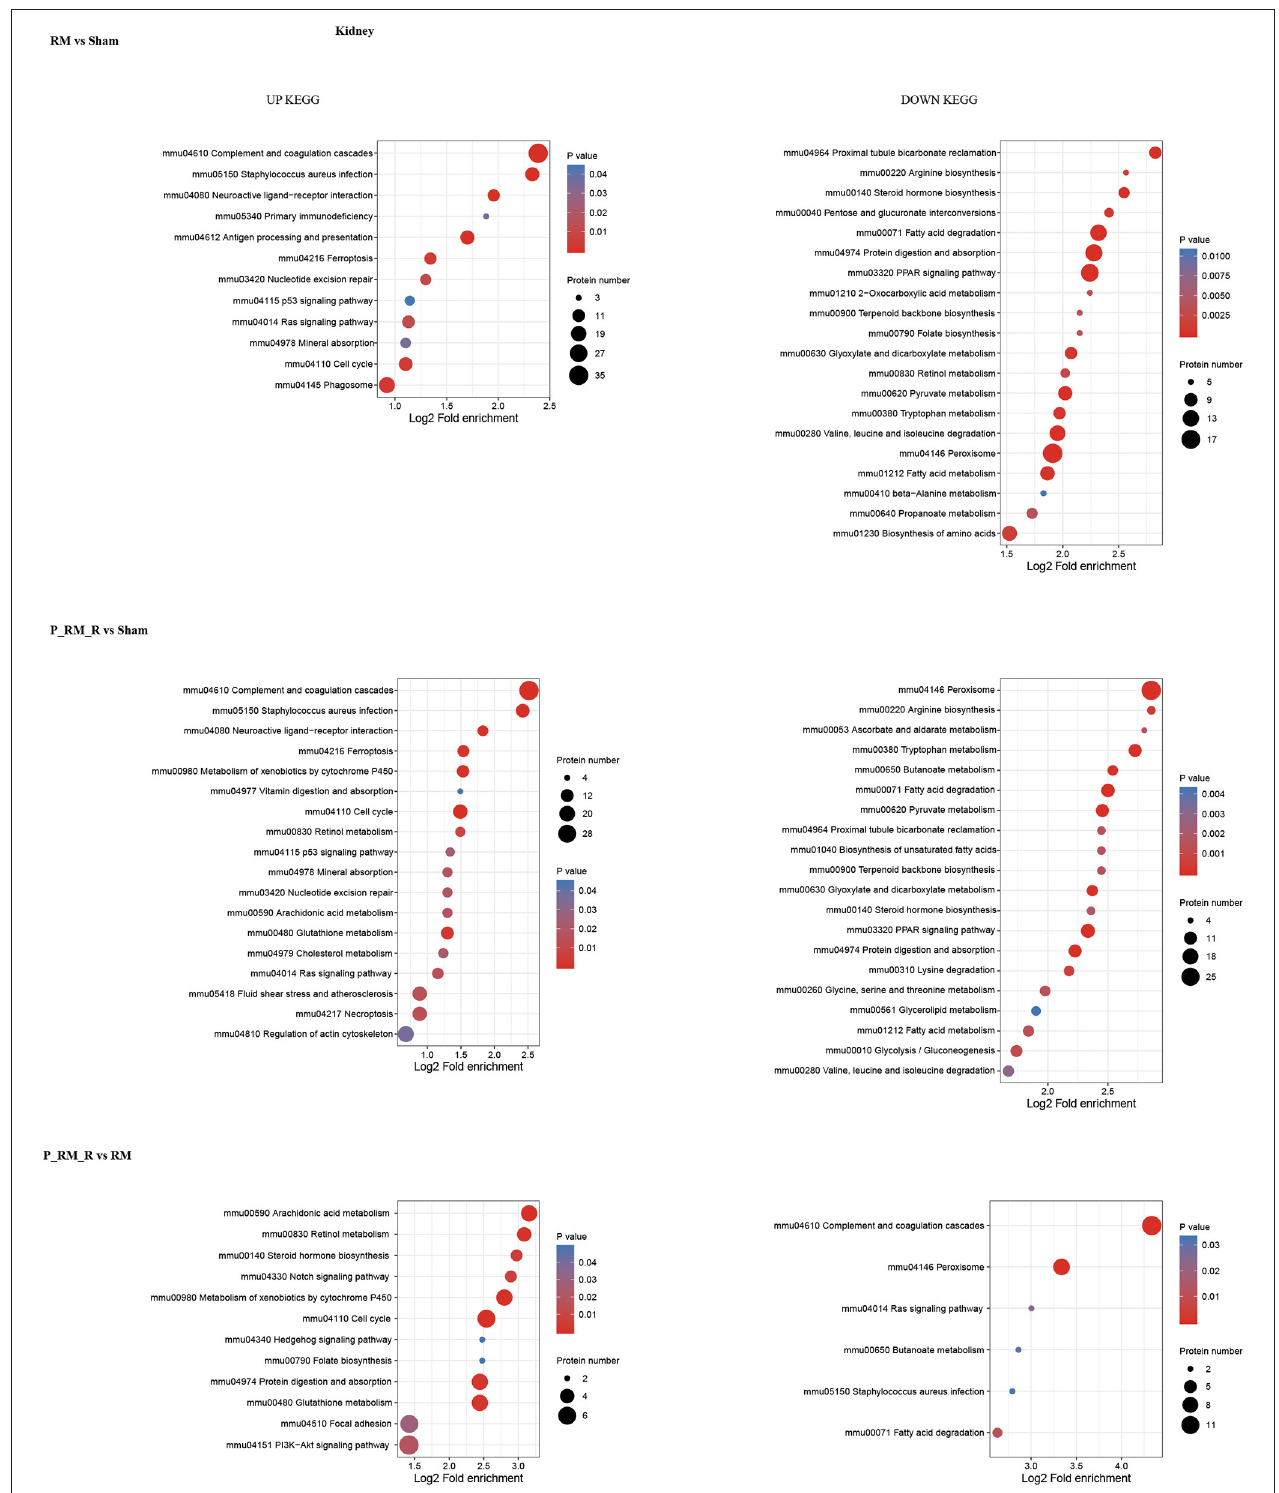
FIGURE 3 | KEGG pathway enrichment of proteins in kidney tissue. RM, rhabdomyolysis; P_RM_R, the mouse in the parabiosis model administered glycerol; P_RM_S, the other mouse in the parabiosis model supplying the exogenous biological renal support.